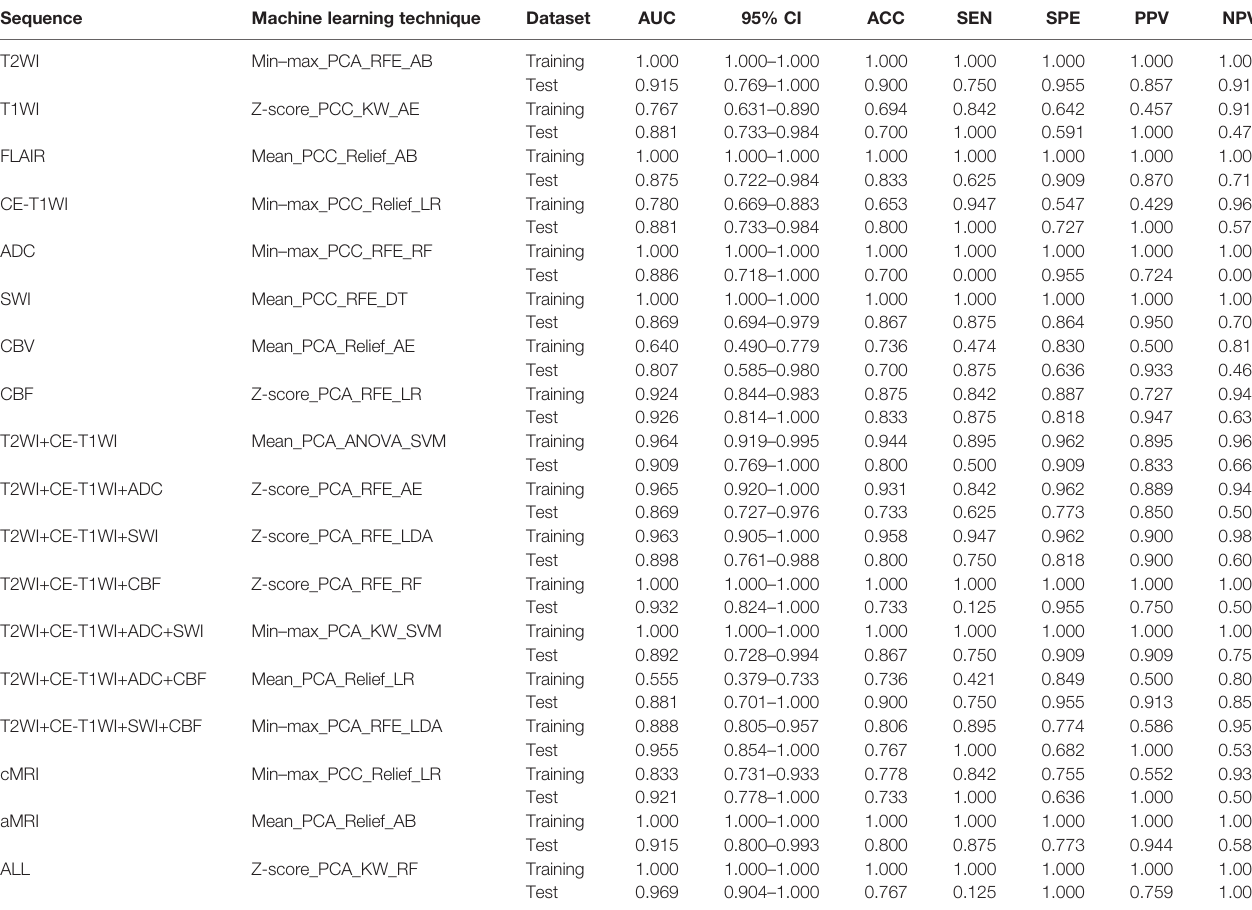
TABLE 2 | The performance of the top-one-performing models.